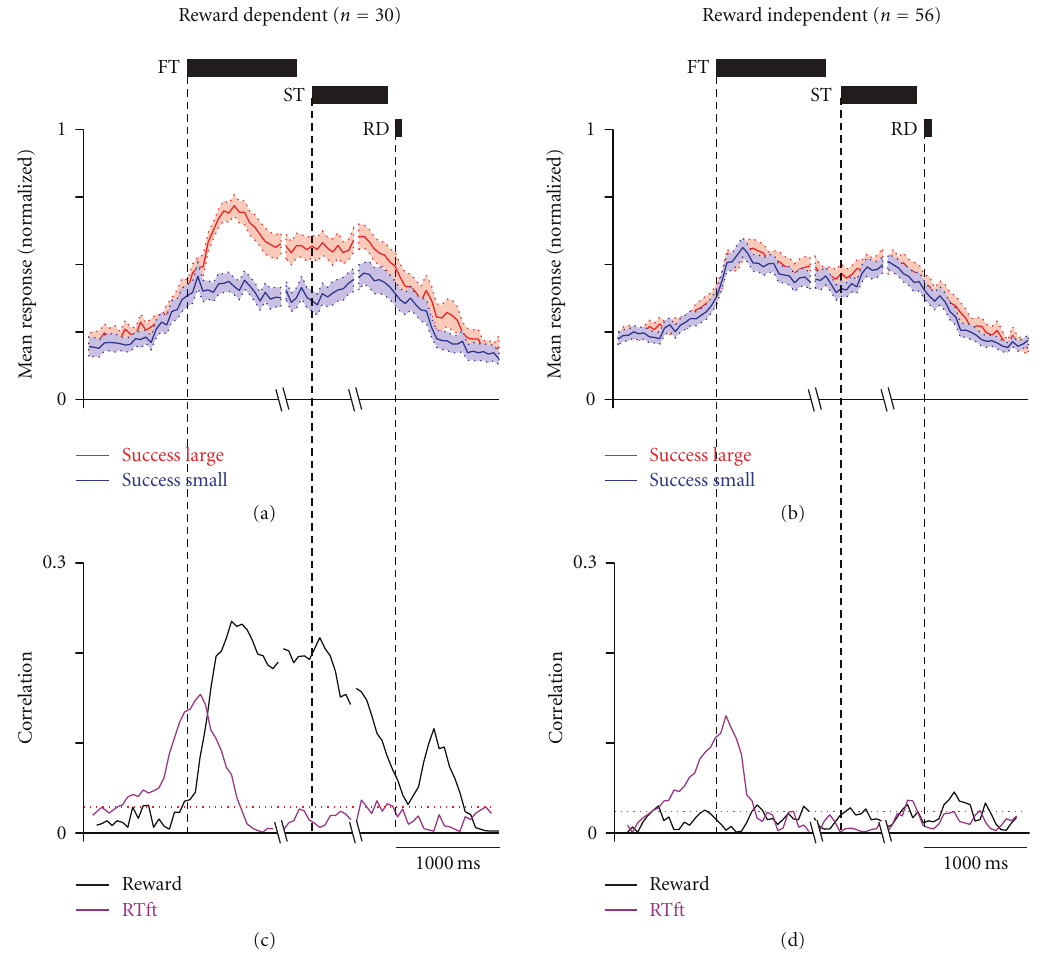
Figure 4: Correlations between PPTN neuronal responses with reward value and task performance. (a, b) Population spike density function of reward magnitude-dependent (a) and -independent (b) fixation target-responsive neurons averaged for large- (red) and small- (blue) reward trials, aligned to fixation target onset, saccade target onset, and reward delivery. The spike density is the population average normalized for the peaks of the individual neurons. The thick lines indicate the mean normalized activity, and the light-shaded areas are ± 1 SEM. (c, d) Correlation coe ffi cient (absolute value) plots of the neuronal responses shown in (a) and (b) with the reaction time to fixate upon the fixation target (purple) and the reward magnitude (black). The horizontal dotted red line indicates the significance level ( P = 0 . 05) of the correlations. FT: fixation target, ST: saccade target, RD: reward delivery. (Modified from